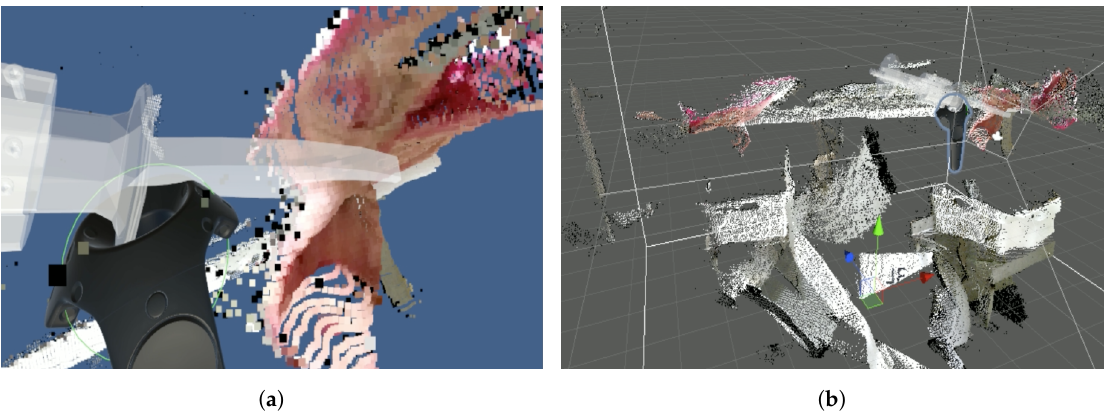
Figure 7. Cutting pose demonstration in VR. ( a ) View in the VR headset. ( b ) Scene